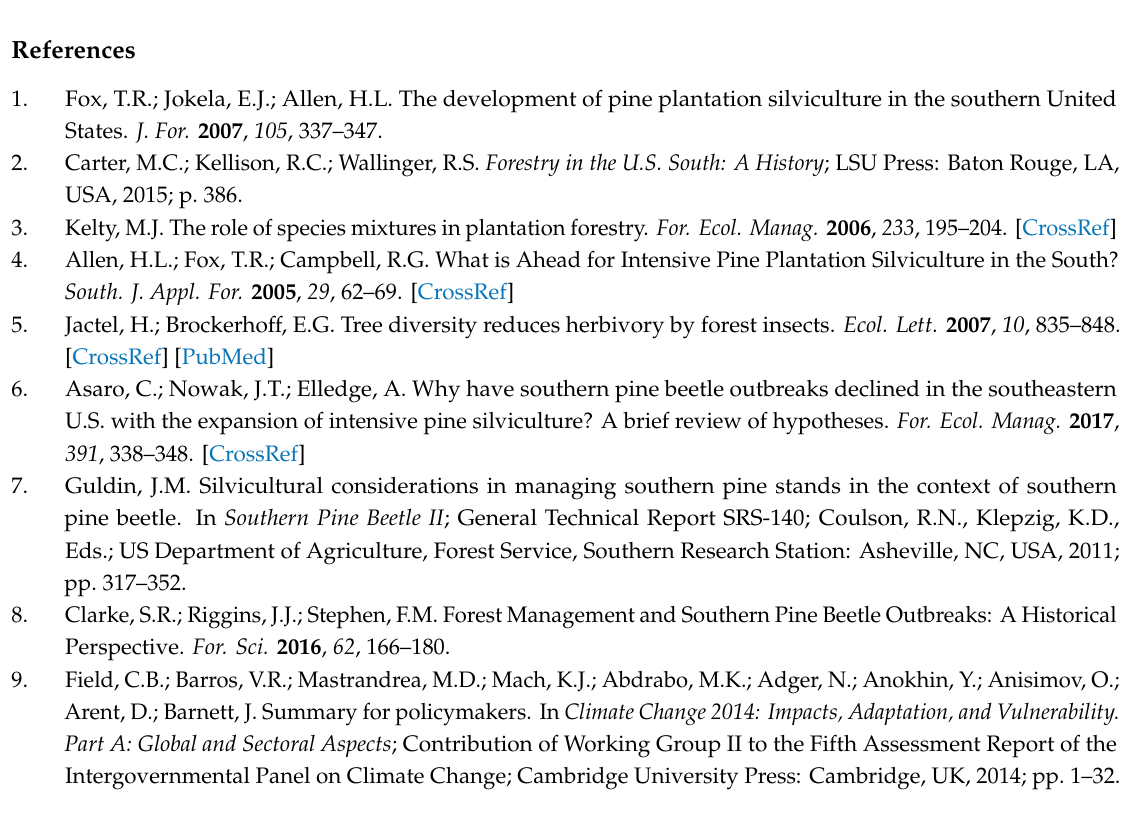
Table S1: Cash Flow Assumptions and Cash Flow